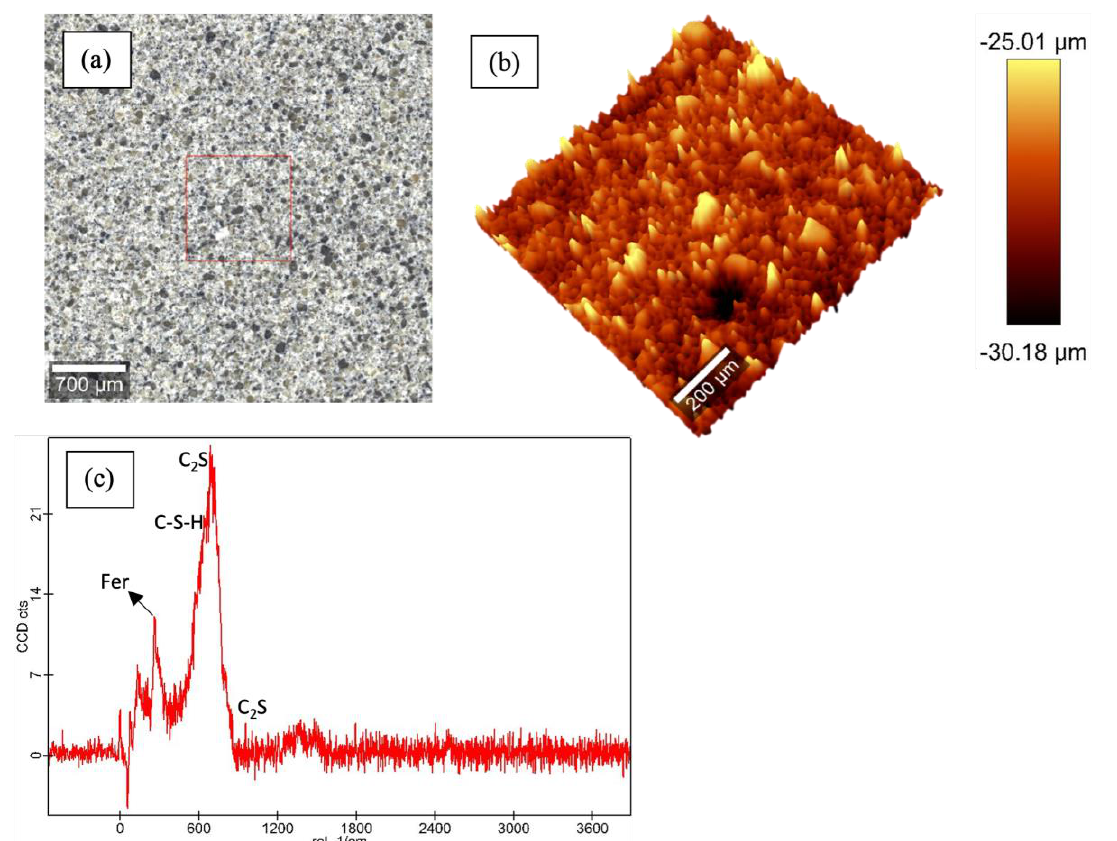
Figure 6. Raman results for polished cores of 30% ferrierite-added Class-H cement: ( a ) optical micrograph of polished cement core; ( b ) large-area profilometry scan of the cement; ( c ) phase peaks for ferrierite, C-S-H and C 2 S are observed in this plot. However, C 3 A was not resolved well in these scans.